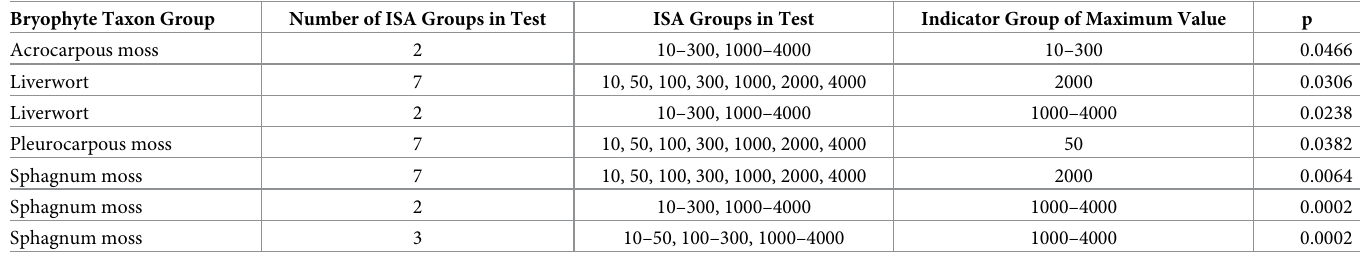
Table 7. Indicator species analysis of bryophyte taxon groups by distance class groups from the DMTS haul road, CAKR. Only results with p values < 0.05 are shown below. Hylocomium splendens does not appear as all indicator values for this group had p values > 0.05. Tests were run for each distance class individually and for 10–300 m vs. 1000–4000